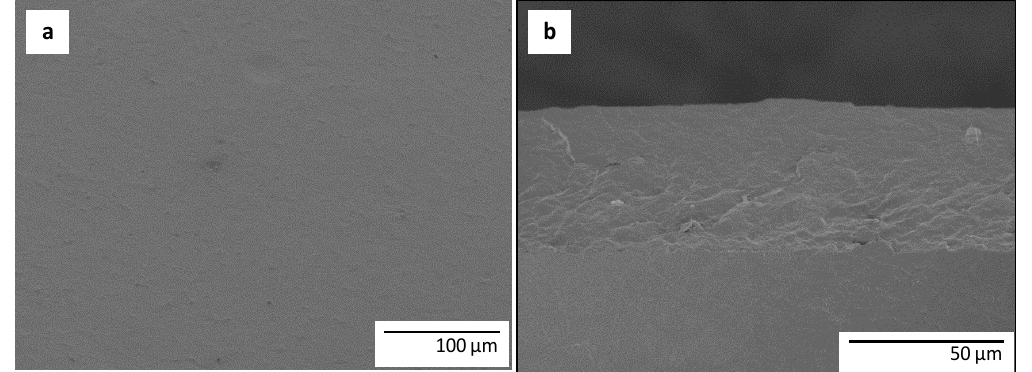
Figure 3. SEM micrographs of the active multilayer; ( a ) top view of the film; ( b ) side view of the cryo-fractured film section.